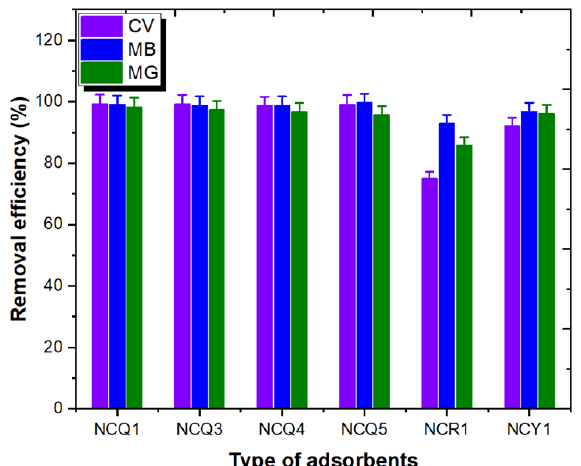
Figure 1 . Adsorption selectivity experiments with dye solutions . Figure 1. Adsorption selectivity experiments with dye solutions.